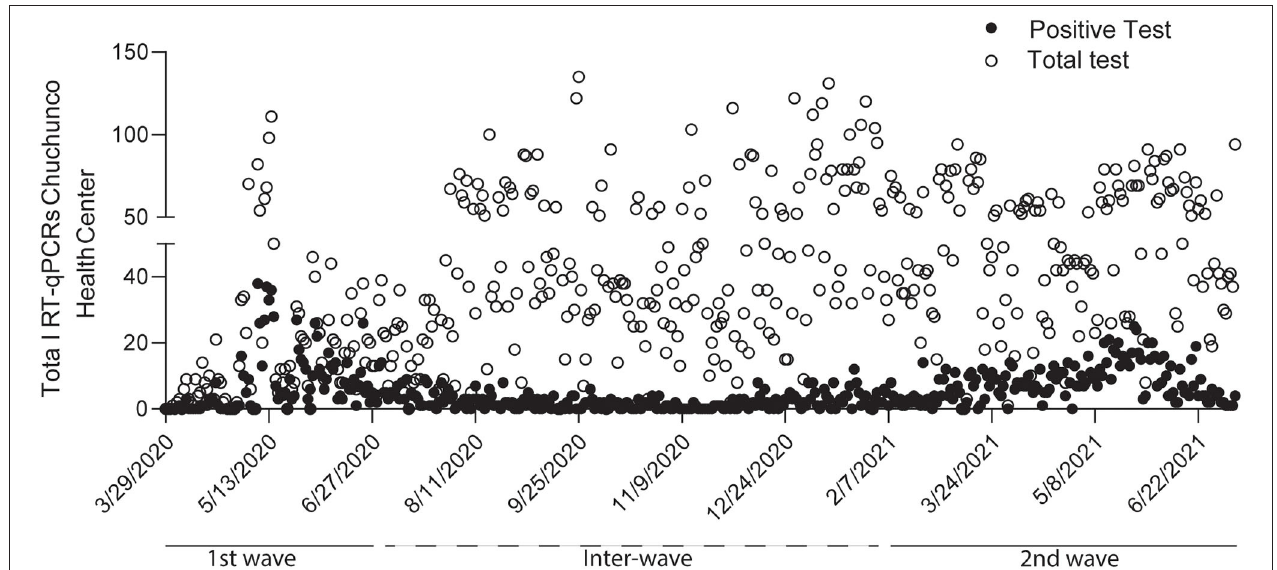
FIGURE 1 | Confirmed patients in the Chuchunco primary health center during the first and second waves of infections in Santiago de Chile. The analyses include 1,694 patients distributed between the first wave (March to July 2020), inter wave (August 2020 to January 2021), and second wave (January to June 2021). The analyses include 666, 323, and 705 confirmed positive cases, respectively. Black circles correspond to positive cases, and open circles correspond to total tests carried out in the health